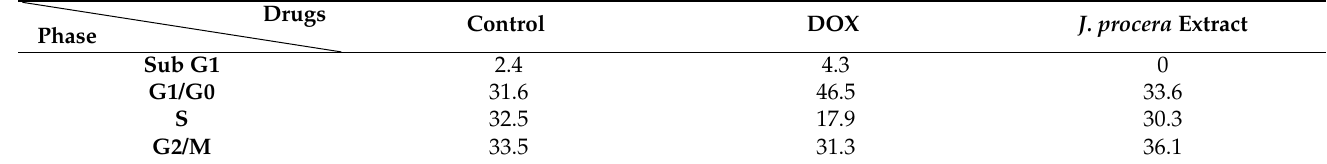
Table 6. Percentage of HCT 116 cells treated with DOX and the IC 50 of J. procera methanolic extract for 24